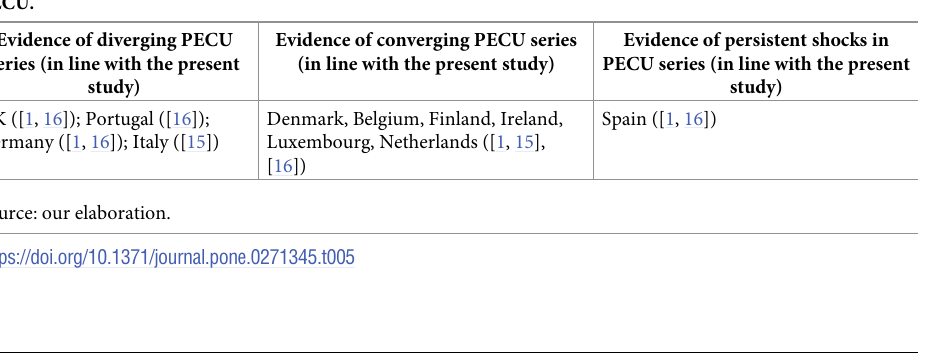
Table 5. Classification of previous studies’ results and comparison our stochastic convergence outcomes for PECU. Evidence of diverging PECU Evidence of converging PECU series series (in line with the present (in line with the present study) study) UK ([1, 16]); Portugal ([16]); Germany ([1, 16]); Italy